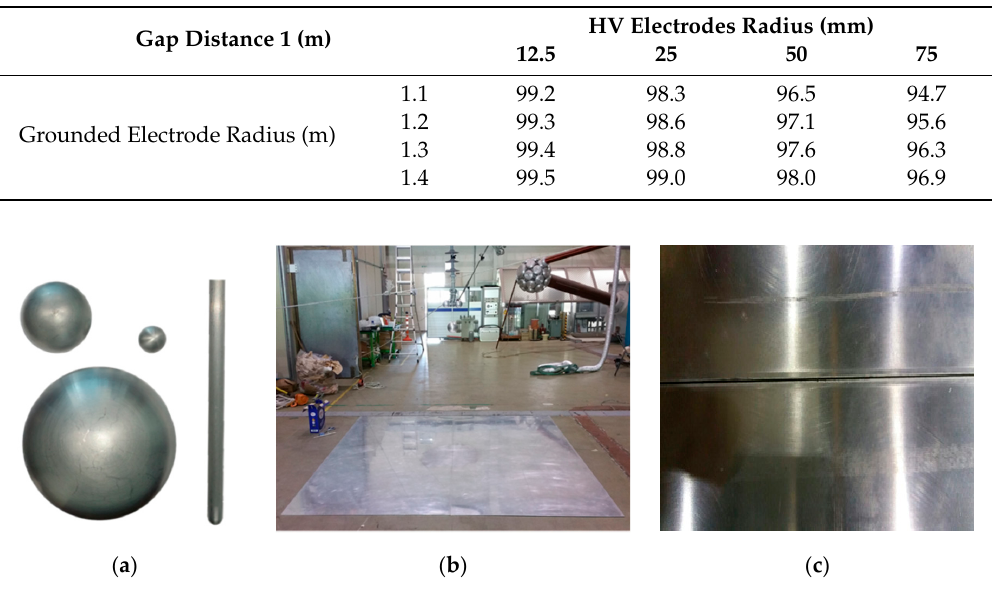
Figure 2. Experimental set-up (( a ) HV electrodes, ( b ) test view ( c ) contact of grounded electrode). Table 2. Detailed electric field analysis result.